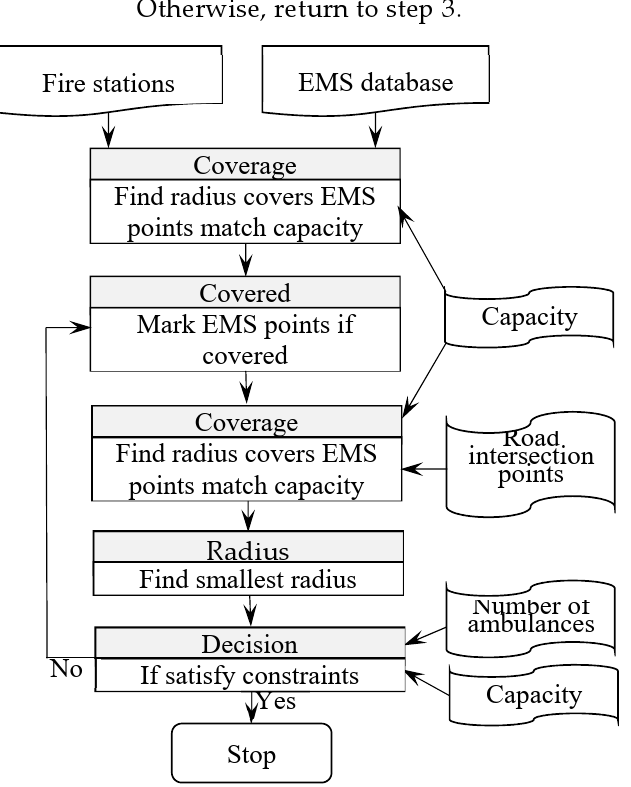
Figure 1. Procedures of the dynamic floating stations model (DFSM).